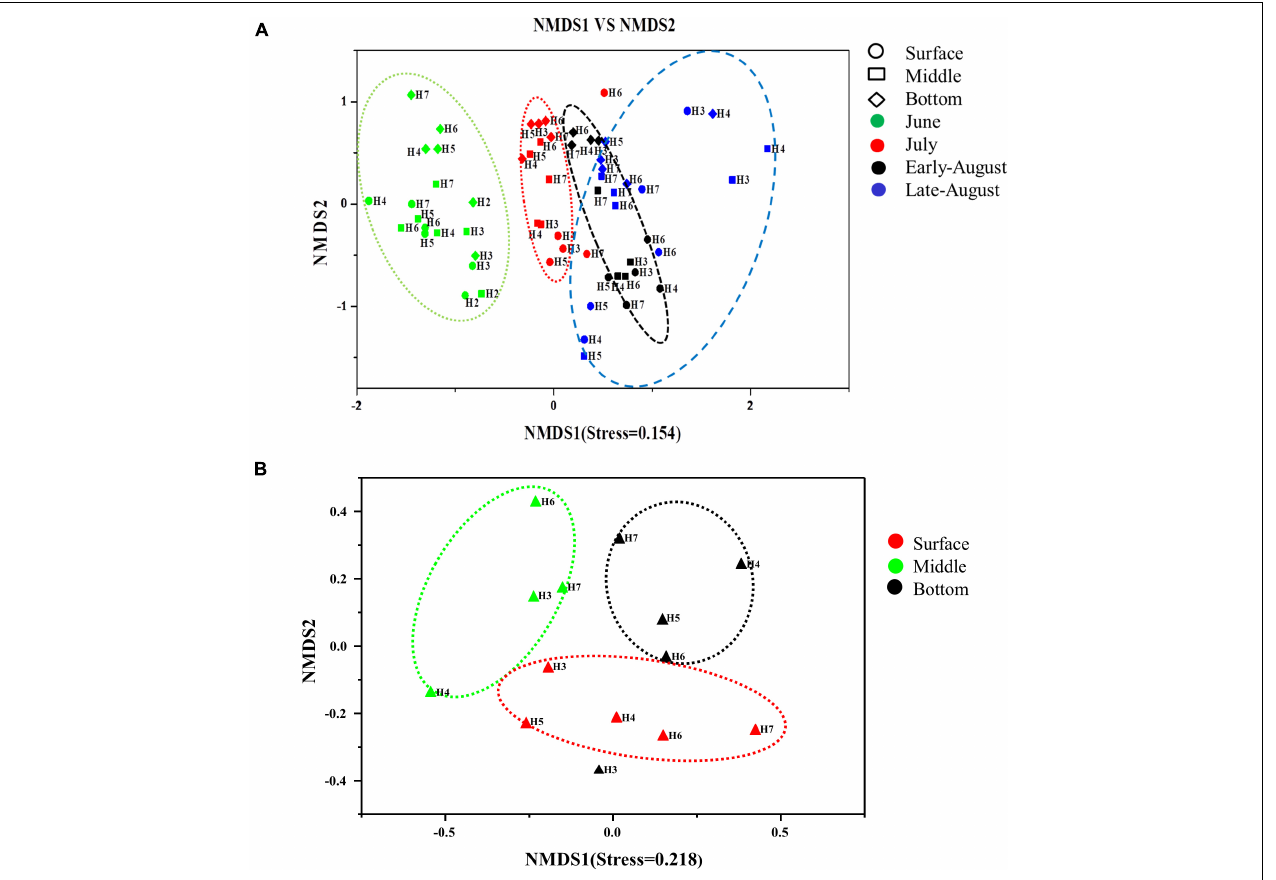
FIGURE 5 | Non-metric multidimensional scaling (NMDS) plot depicting distribution pattern of 16S rRNA (A) and nosZ gene (B) bacteria. Axis defines 2D space that allows the best spatial representation of sample distance, based on binary Jaccard distance with stress = 0.154 (A) , stress = 0.218 (B) . The points in the figure represent different sampling times, symbols represent different water layers, and the distance between points represents the degree of